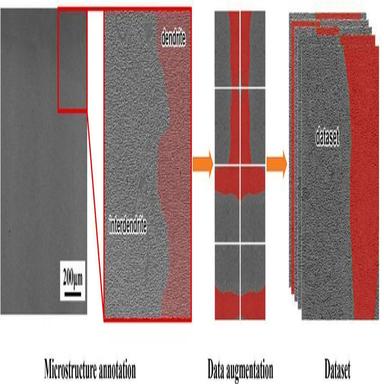
Dataset generation and augmentation. Raw images were segmented into sub-images which were labeled into four classes (interdendritic as background, dendrite, eutectic and pore as objects). The data augment strategy was utilized to enlarge the dataset.